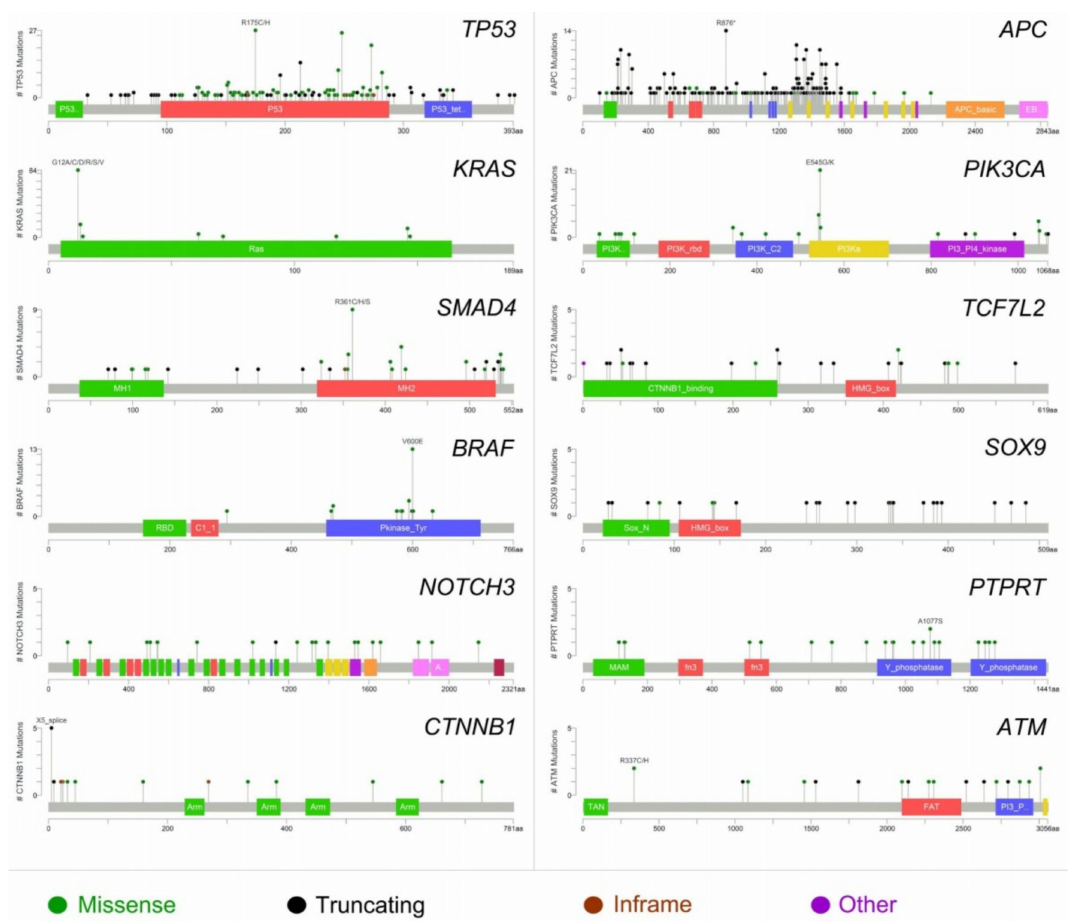
Figure 2. Domain structure and gene alterations of the 12 most frequently altered genes in colorectal cancer liver metastases (312 patients, 318 samples from cBioPortal). Mutation types are color-coded on the basis of the legend at the